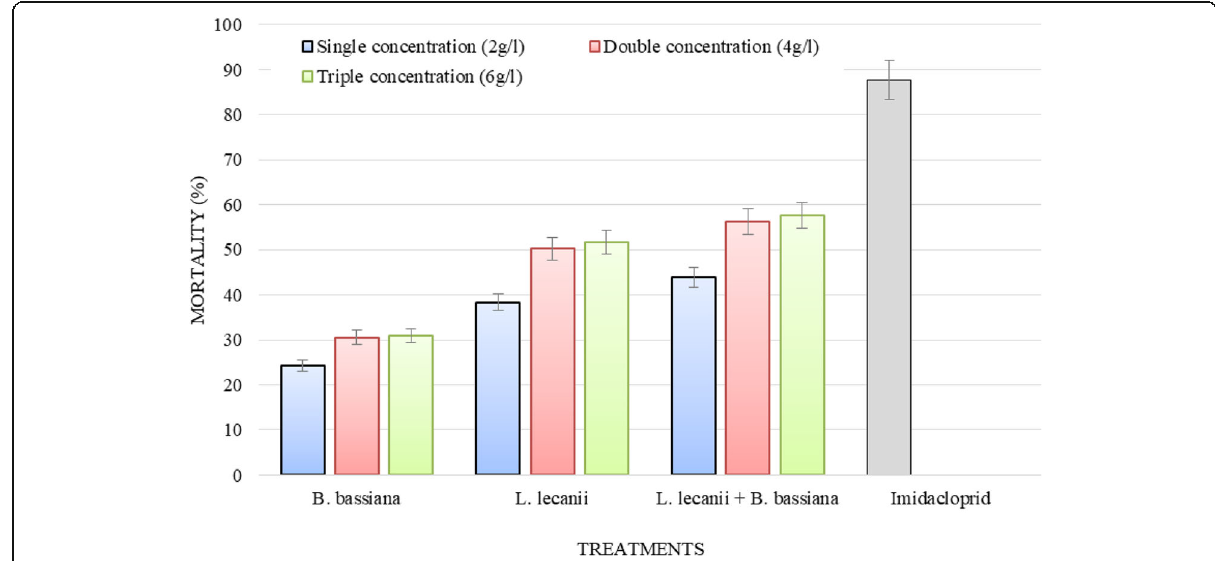
Fig. 1 Comparatice efficacy of Lecanicillium lecanii and Beauveria bassiana against Maconellicoccus hirsutus under laboratory